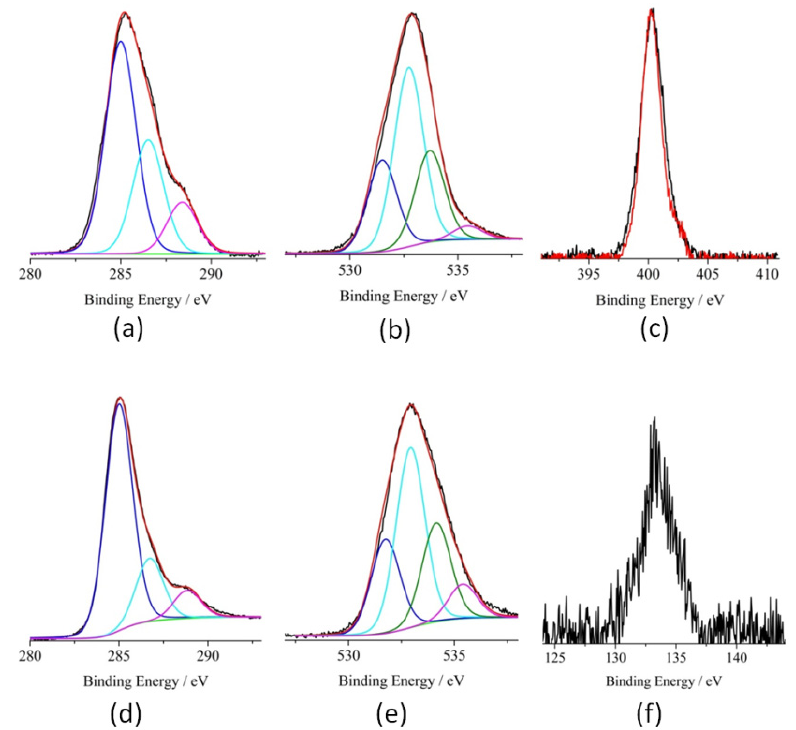
Figure 4. Al-K α excited XPS of: ( a , b ) isox -GQDs 2a in the C 1s and O 1s binding energy regions; ( c ) overlapped XPS of the isox -GQDs 2b (black line) and isox -GQDs 2a (red line) in the N 1s binding energy region; ( d , e ) isox -GQDs 2b in the C 1s and O 1s binding energy regions; ( f ) isox -GQDs 2b in the P 2p binding energy region.